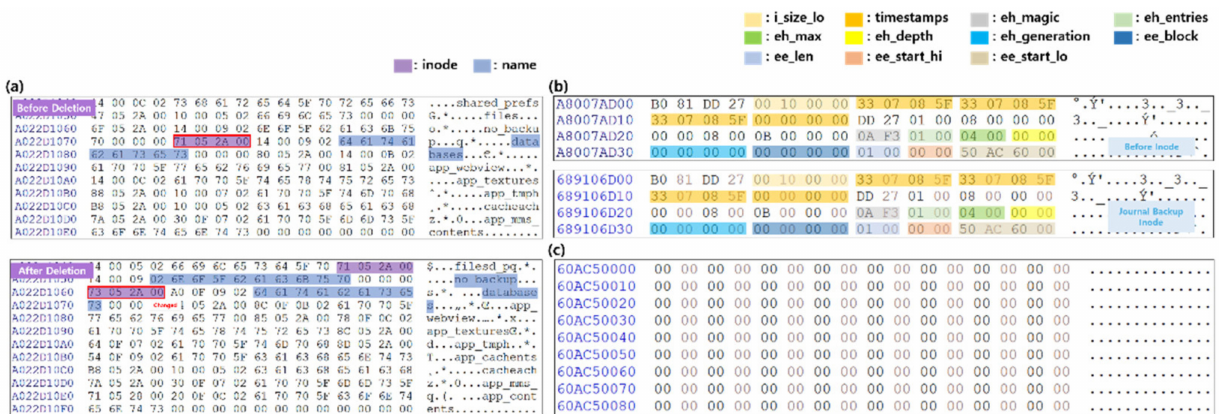
Figure 8. Metadata analysis of filesystem before and after data deletion using scenario II ( a ) Com- parison of/data/data/com.kakao.talk’s inode before and after deleting app data ( b ) Comparison of kakaotalk.db’s inode before deletion and journal backup inode ( c ) Kakaotalk.db’s data area searched based on journal backup. The red box indicates changed fields before and after